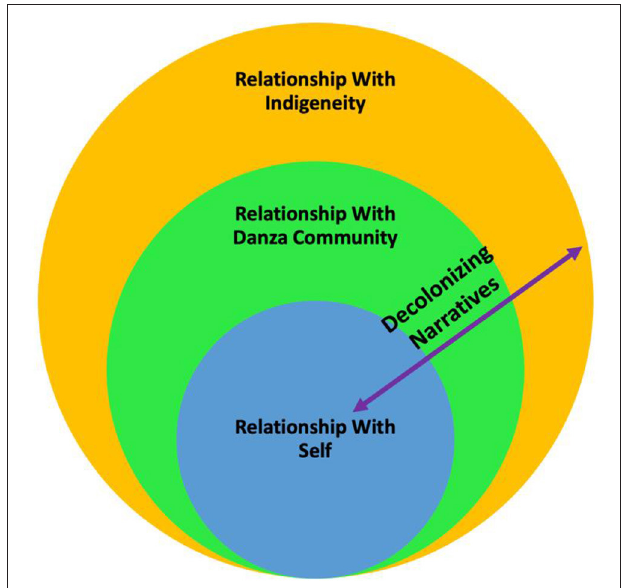
FIGURE 1 | Decolonizing narratives of the health analytic